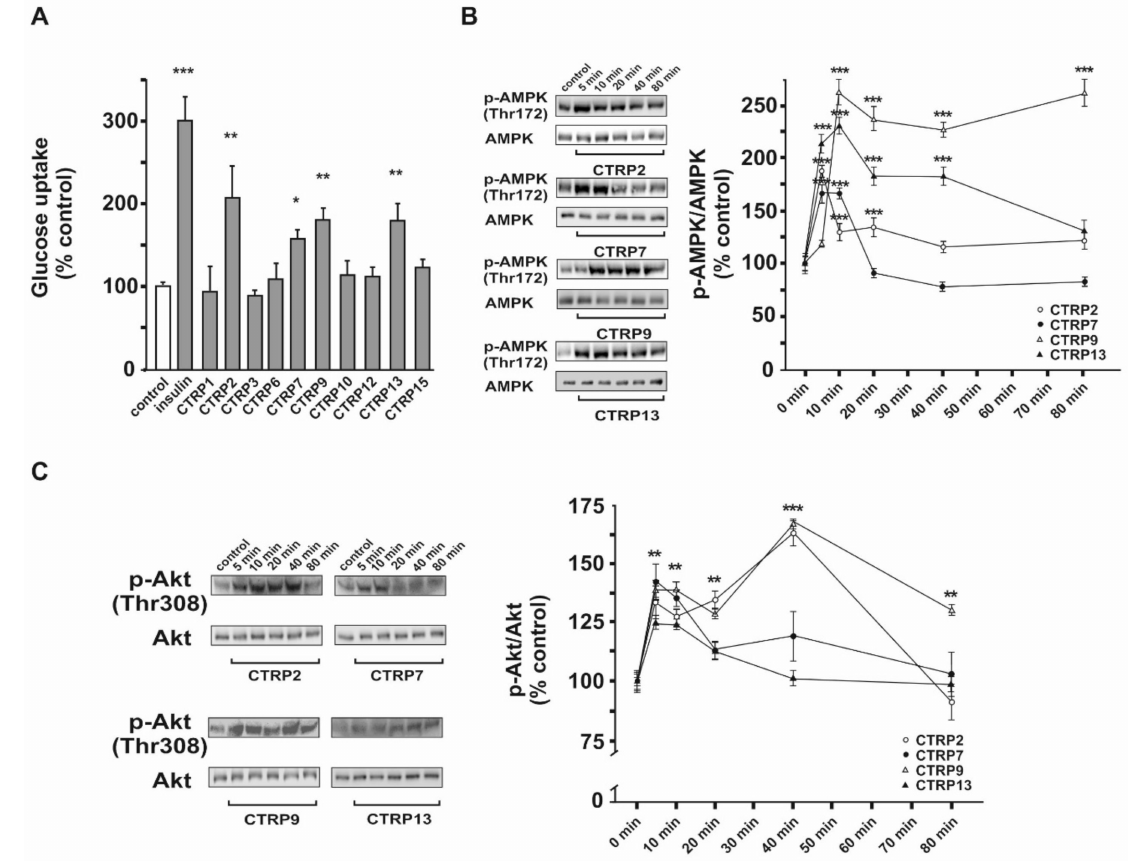
Figure 2. Glucose uptake and phosphorylation of AMPK and Akt in response to CTRPs in adult rat cardiomyocytes. ( A ) Following treatment with insulin (100 nM) or CTRPs for 1 h in DMEM without serum and glucose after 3 h glucose starving, glucose uptake was measured. ( B ) Western Blots were performed for phosphorylation of AMPK during the time course experiments for CTRP2, CTRP7, CTRP9 and CTRP13. Total AMPK served as loading control. The results of the densitometric evaluation are shown on the right. ( C ) Western Blots and densitometry for phosphorylation of Akt, as described in ( B ). Data are mean ± SEM from 5 independent experiments, with 2 biological replicates, each. * p < 0.05, ** p < 0.01, *** p < 0.001 vs. control, unless otherwise